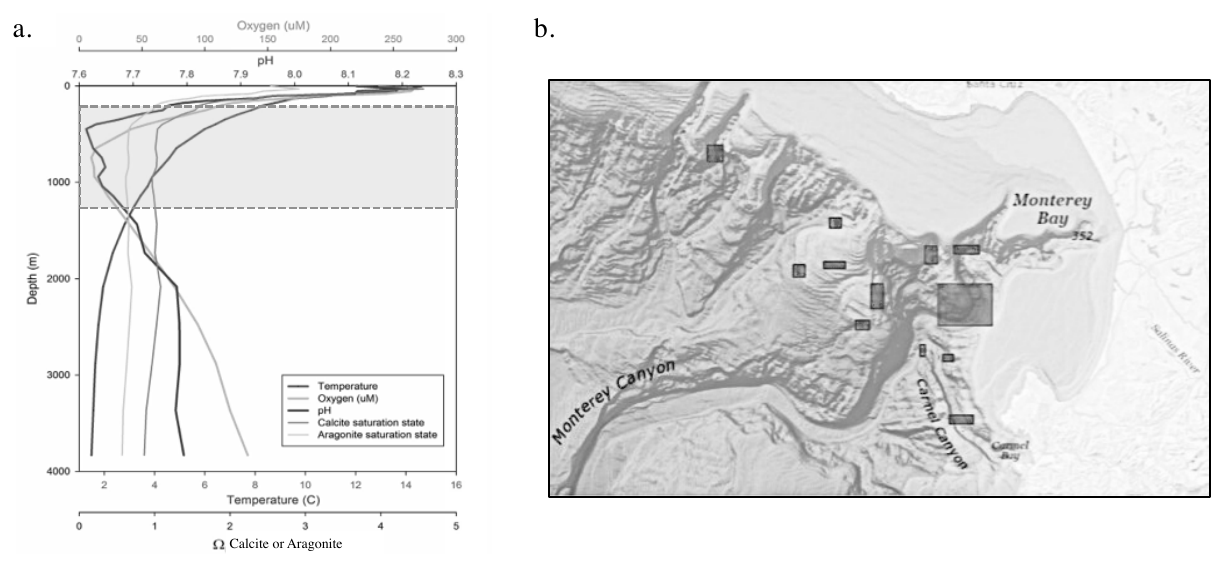
Figure 1. S. fragilis lives at depths of 200-1200 m in Monterey Bay, CA, in seawater with chemistry approximating that described in the shaded area of (a). Urchins were collected within the boxed regions of Monterey Bay, CA (b), at depths of 500-1,000 m, during ROV dives in late 2010 and early 2011. Data shown in (a) acquired from the World Ocean Circulation Experiment (WOCE) station P17C (central CA coast).